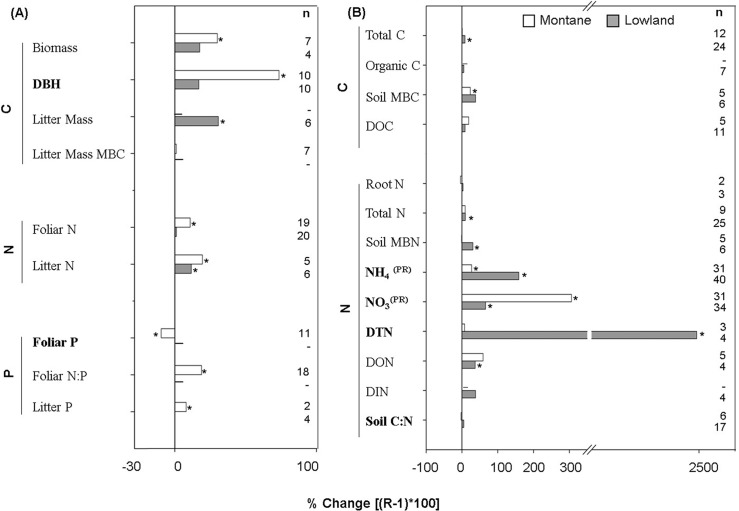
Percentage of change for response pools in (A) aboveground and (B) belowground variables.An asterisk represents significant percentage of change with the N addition. A PR superscript represent a significantly different change between montane and lowland forests (ProRand ≤ 0.05). Bolded variables represent significant associated total heterogeneity (Qt; p ≤ 0.05). n represent the number of pair comparison between control and experimental N-supply.